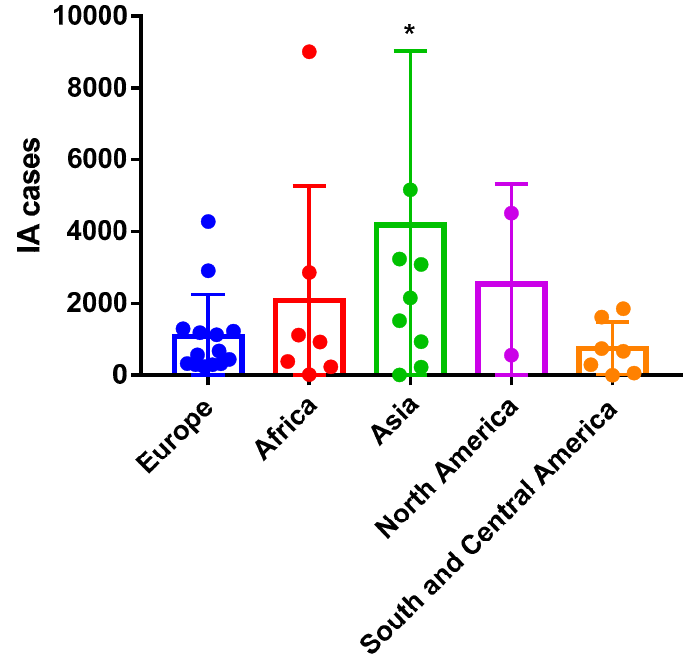
Figure 2. Prevalence of invasive aspergillosis in a continental level. * p < 0.05.